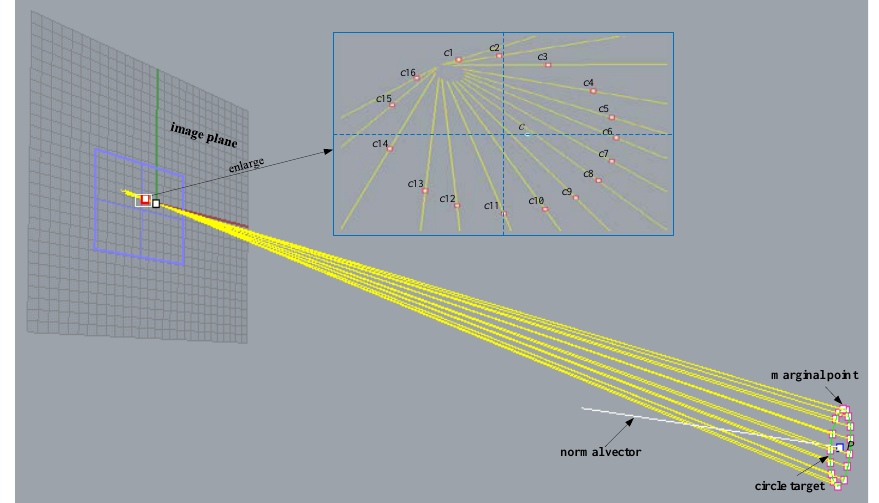
Figure 5. Simulation diagram of the space circular target mapping model.